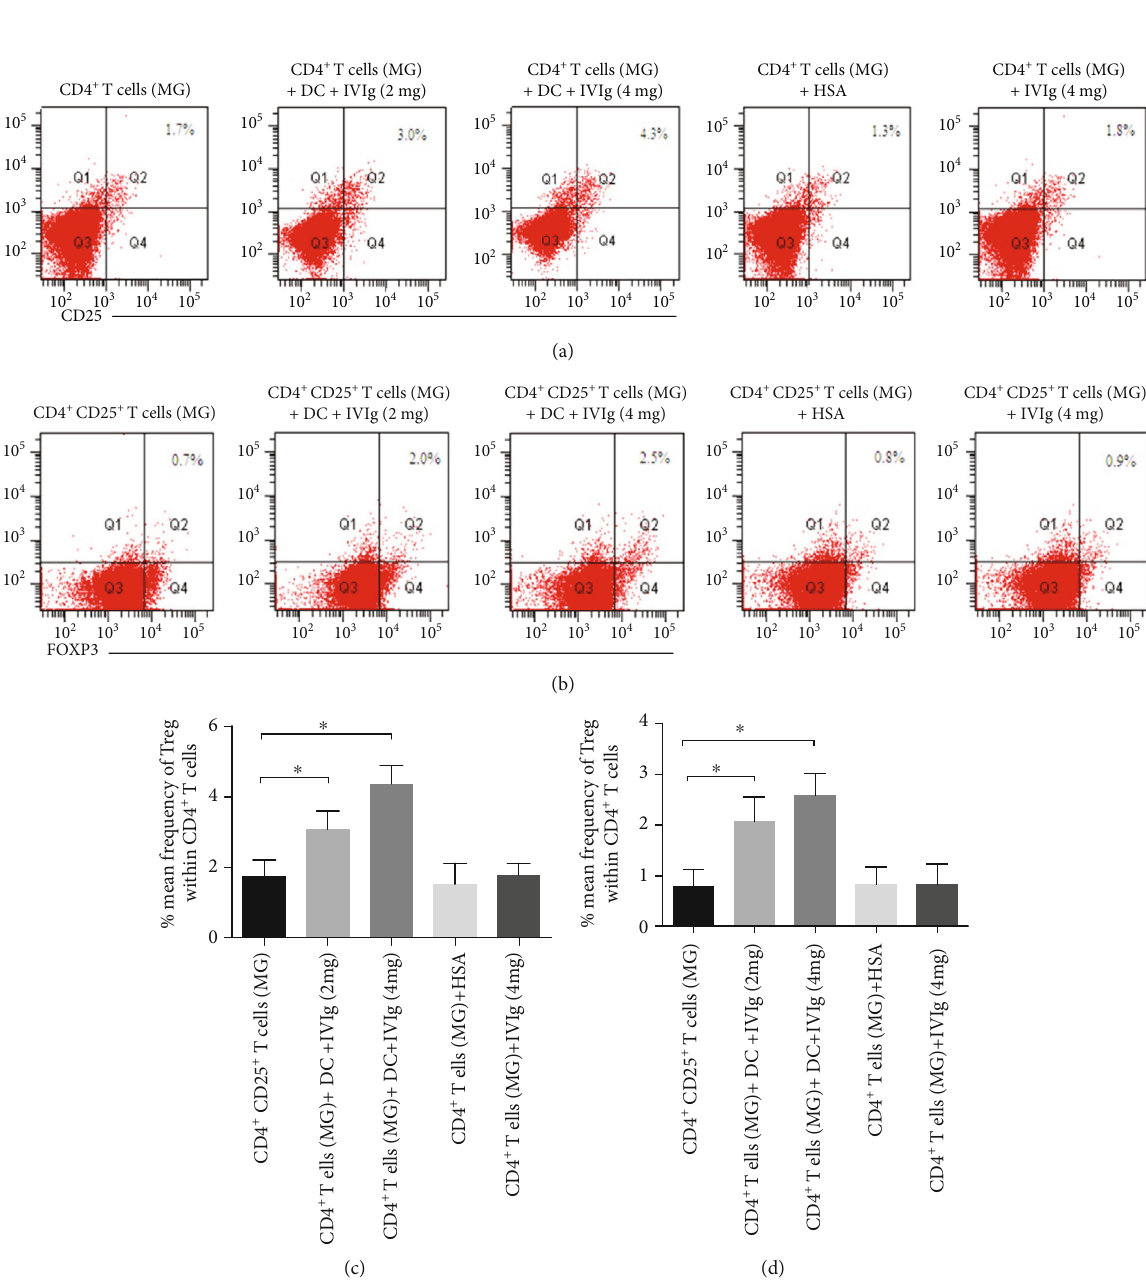
Figure 4: IVIg therapy induces Treg and CTLA-4 + Treg cells through DCs in MG. Monocyte-derived DCs from MG patients were treated with vehicle, 2mg/ml or 4mg/ml IVIg and then cocultured with CD 4+ T cells from PBMC of MG patients for 4 days. Treg cells (CD4 + CD25 + FOXP3 + ) and CTLA-4 + Treg cells (CD4 + CD25 + FOXP3 + CTLA-4 + ) were then detected by fl ow cytometry (a, b). At least three independent experiments were performed and statistical signi fi cance was determined by T test (c, d). Data are expressed as mean ± SD . ∗ P < 0 : 05